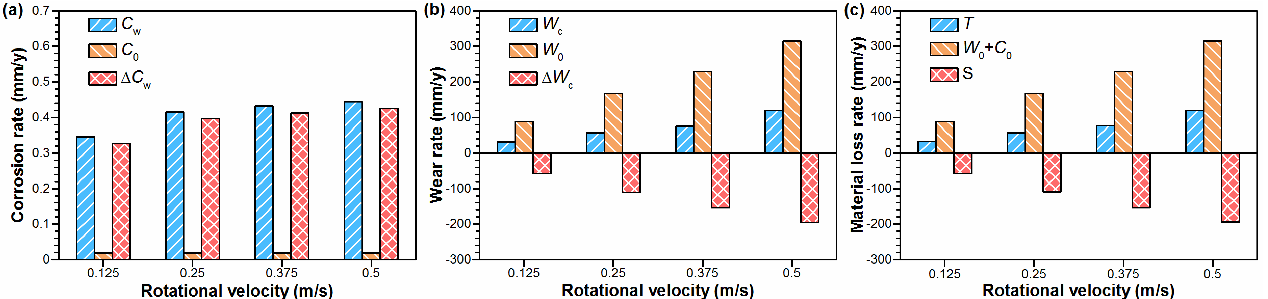
Figure 4. ( a ) The total corrosion rate ( C w ), pure corrosion rate ( C 0 ) and the change in corrosion caused by mechanical wear (∆ C w ); ( b ) total wear rate ( W c ), mechanical wear rate ( W 0 ) and the change in wear rate caused by corrosion (∆ W c ); and ( c ) the contribution of wear ( W 0 ), corrosion ( C 0 ) and mechanical wear-corrosion interaction ( S ) in total material loss rate ( T ), at different rotational velocities in seawater.